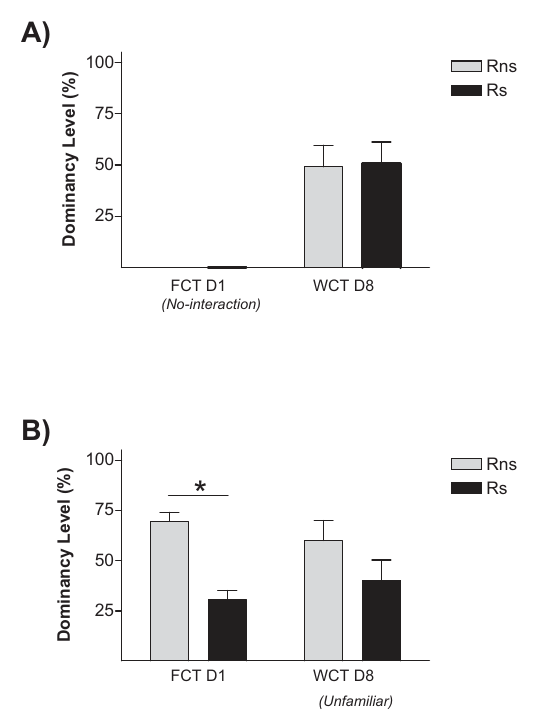
Figure 5. Specificity of the memory in stress-induced social hierarchy rank. Graphs show dominancy level percent in (A) Ps confronted only on day 8 (7 days after Rs were stressed), no differences were found in dominancy level between Rns and Rs, indicating that stress does not render animals submissive when they compete on day 8 and (B) , stress rats confronted with unfamiliar rats not only during the FCT but as well in the WCT, no differences werefoundonday8betweenRnsandRs,overrulingthehypothesisthatstress potentitates memory for the social status acquired on day 1. * p<0.05.